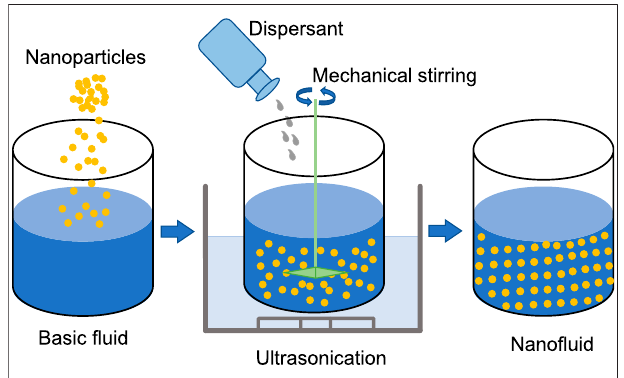
FIGURE 1 | Schematic diagram of preparation of nano fl uids using the two-step